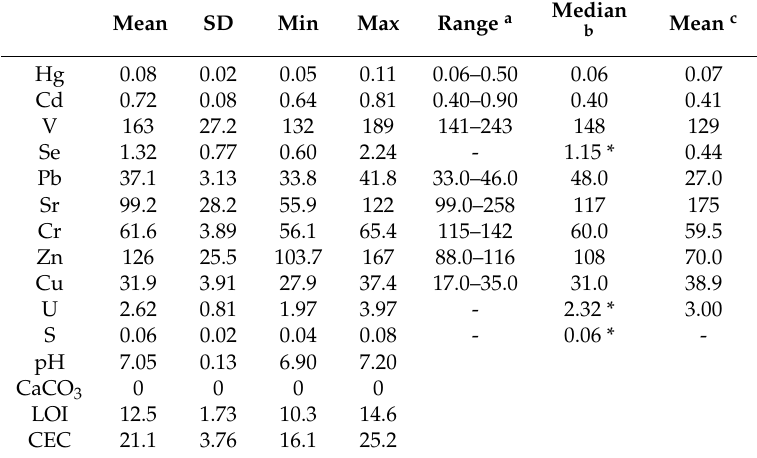
a Element values representative of the Labin area; b Element values representative of the coastal Croatian background; c Summarized world element values; * Element median values representative of the background in EU